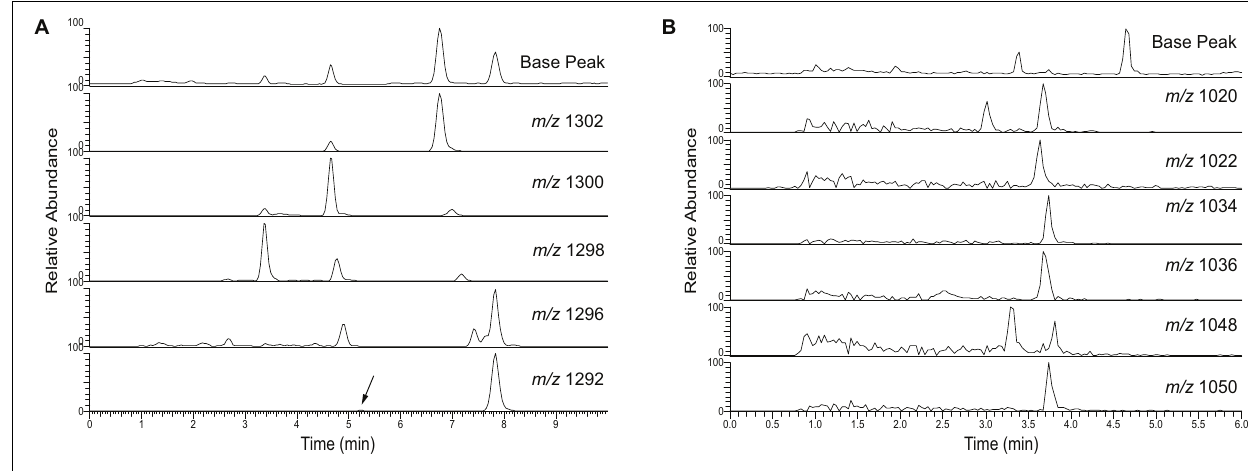
FIGURE 10 | UHPLC analyses of Baltic Sea surface sediment extract showing the base peak chromatogram of (A) isoprenoid GDGTs and (B) branched GDGTs. The arrow indicates the crenarchaeol isomer.